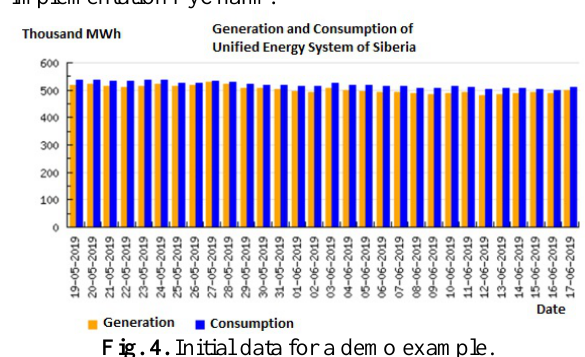
Fig. 4. Initial data for a demo